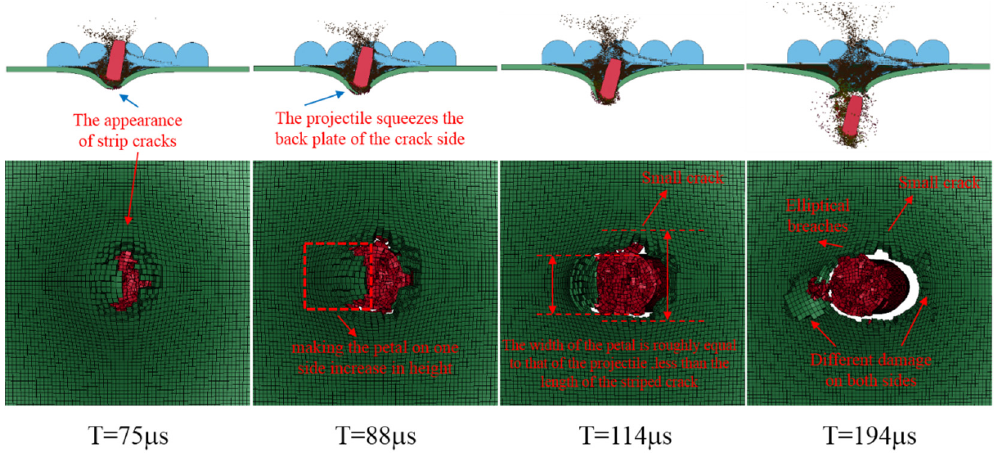
Figure 15. Deformation and failure process of the back plate under working condition 11.